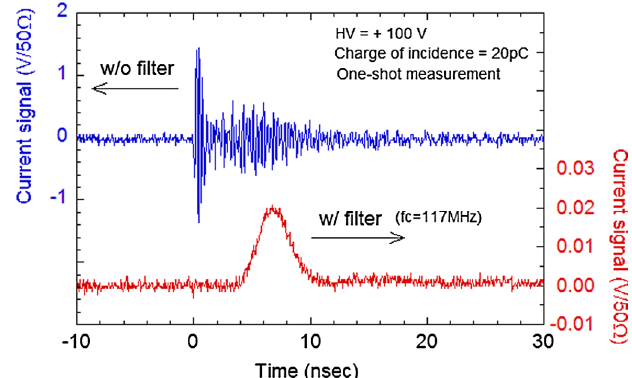
FIG. 12. Effect of induction current before and after suppres- sion. The lower (red) waveform is with LPFs and the upper (blue) waveform is without LPFs.